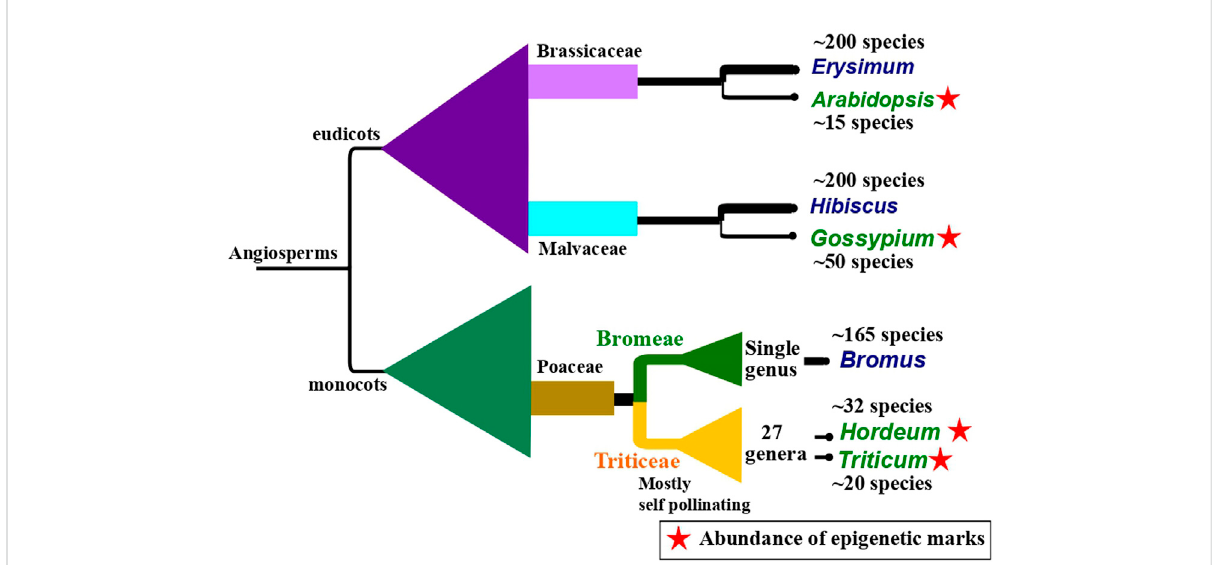
FIGURE 2 An illustration of a hypothesis of evolutionary correlation between the occurrence of self-pollinating species and the presence of abundant epigenetic marks citing three examples found across angiosperm. The illustration shows closely related pairs of sister taxa in which one is predominantlyself-pollinating(taxanameingreen)andtheotheriscross-pollinating(taxanameinblue).Thepredominantlyself-pollinatingspecies, namely, Arabidopsis (Klosinska et al., 2016), Gossypium (Rehman et al., 2021), Hordeum (Guo et al., 2018), and Triticum (Qiu et al., 2017) show high epigenetic marks. The phylogenetic background is drawn to show the relative systematic positions. It is generally assumed that self-pollination has evolved from cross-pollination and self-pollinating taxa have low genetic variability. Higher values in species numbers in predominantly cross- pollinating taxa might be associated with higher genetic variability in these species. The approximate species number for each taxon reported so far, has been taken from World Flora Online (World Flora Online, 2022), except for Bromus (Soreng et al.,